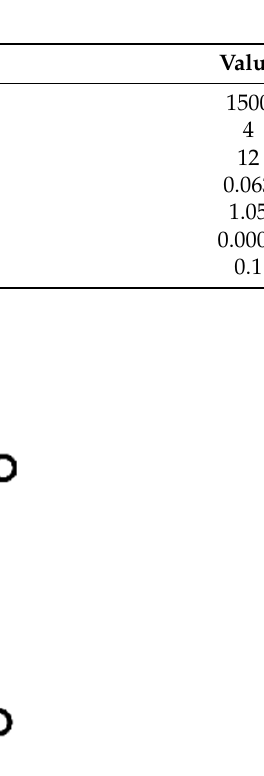
Figure 4. HV source and transformer rectifier modeled in MATLAB/Simulink. Table 3. Rectifier input parameters [24].